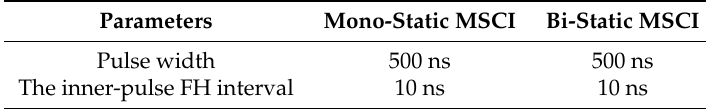
Table 6. Parameters of the transmitted signals in this subsection.